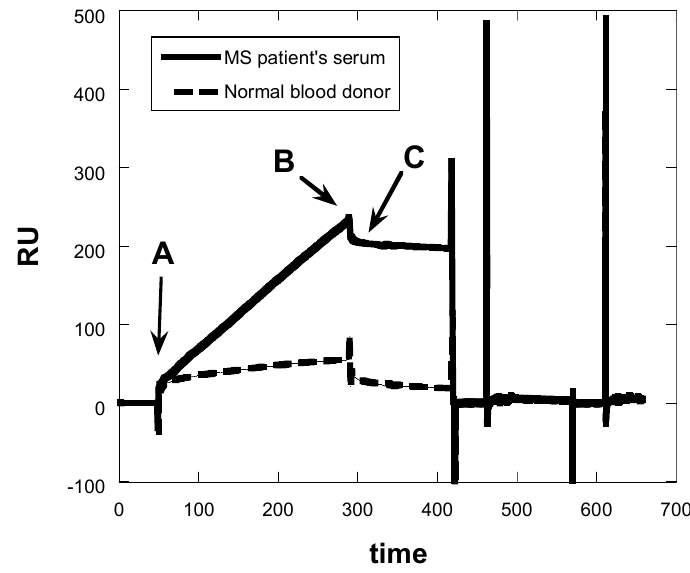
Figure 1. Sensorgram obtained for binding of a MS positive sample and a healthy blood donor sample to the CSF114(Glc)-modified sensor surface. A corresponds to the diluted serum start injection point, which flow through the sensor chip during 240 s. B corresponds to the serum end injection point followed by a buffer wash. C corresponds to the evaluation point 15 s after point B.